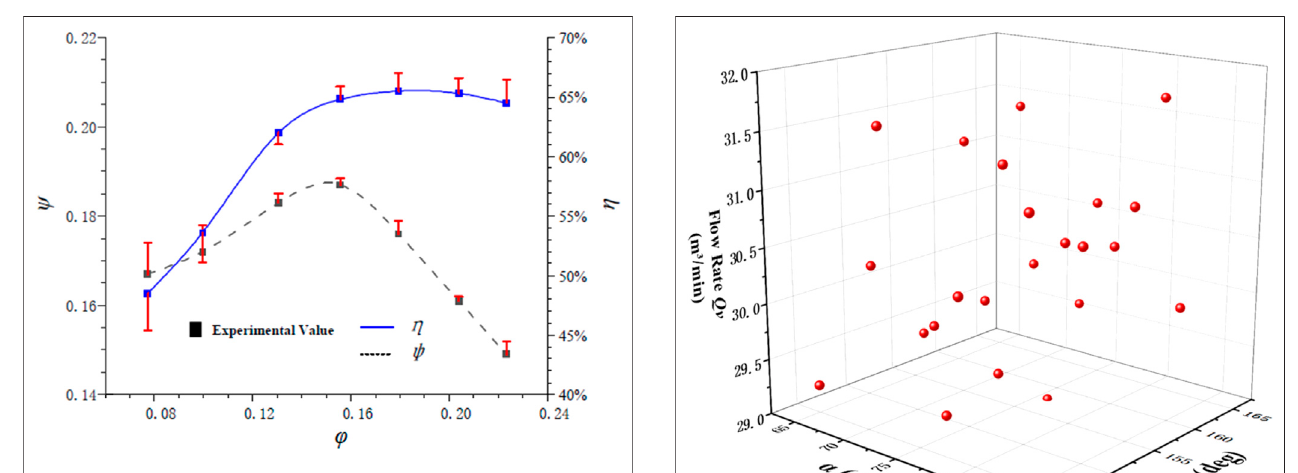
FIGURE 6 | Comparison of test and numerical simulation performance curves.